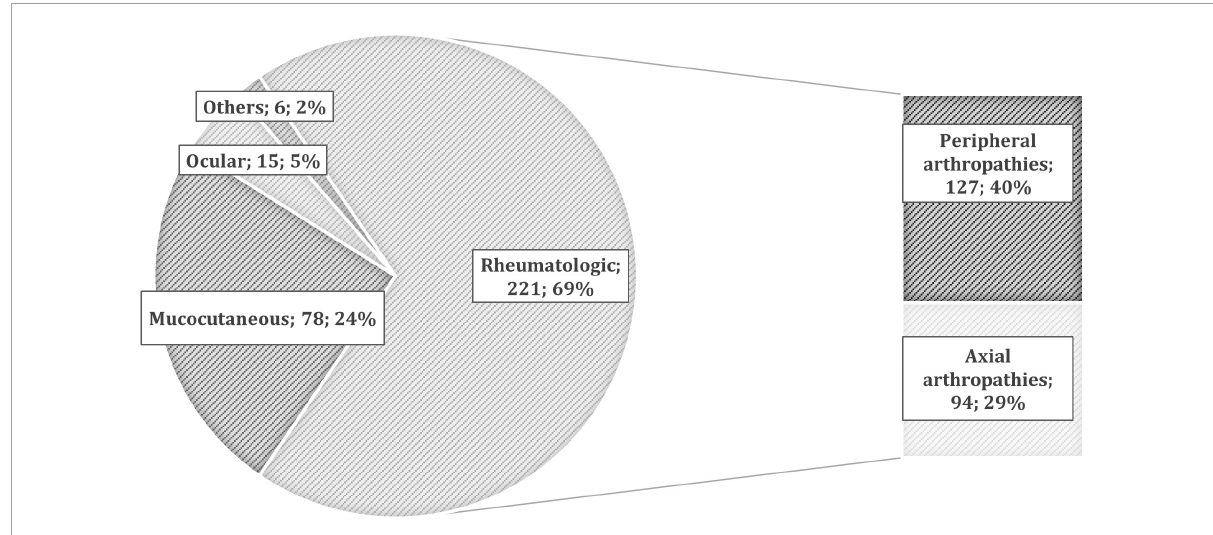
FIGURE1 The prevalence of different extra-intestinal manifestations (EIMs) in patients with inflammatory bowel disease (IBD). According to the European Crohn’s and Colitis Organization (ECCO) definitions (11), we collected 221 rheumatologic EIMs (127 peripheral and 94 axial arthropathies), 78 mucocutaneous (10 pyoderma gangrenosum, 36 erythema nodosum, 21 psoriasis, and 11 others), 15 ocular (6 episcleritis and 9 uveitis), and 6 others [such as primary sclerosing cholangitis (PSC), pancreatitis, and central nervous system manifestations].